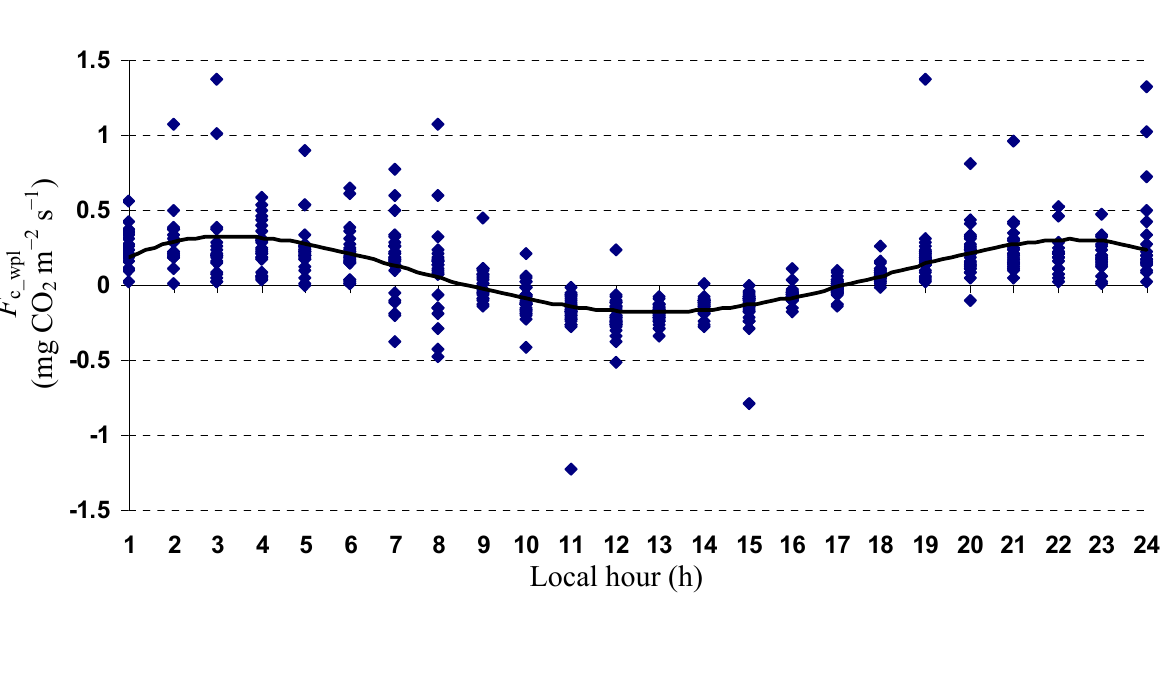
dataset for Yenicaga peatland in September Figure 6. A quartic function fitted to F c_wpl of 2010: F (mg CO m − 2 s − 1 ) = 0.2297 h − 0.0488 h 2 ± 0.0031 h 3 – 6 × 10 − 5 h 4 ; c_wpl 2 ( R 2 = 0.4726; SE = 0.1875; n = 603; P < adj